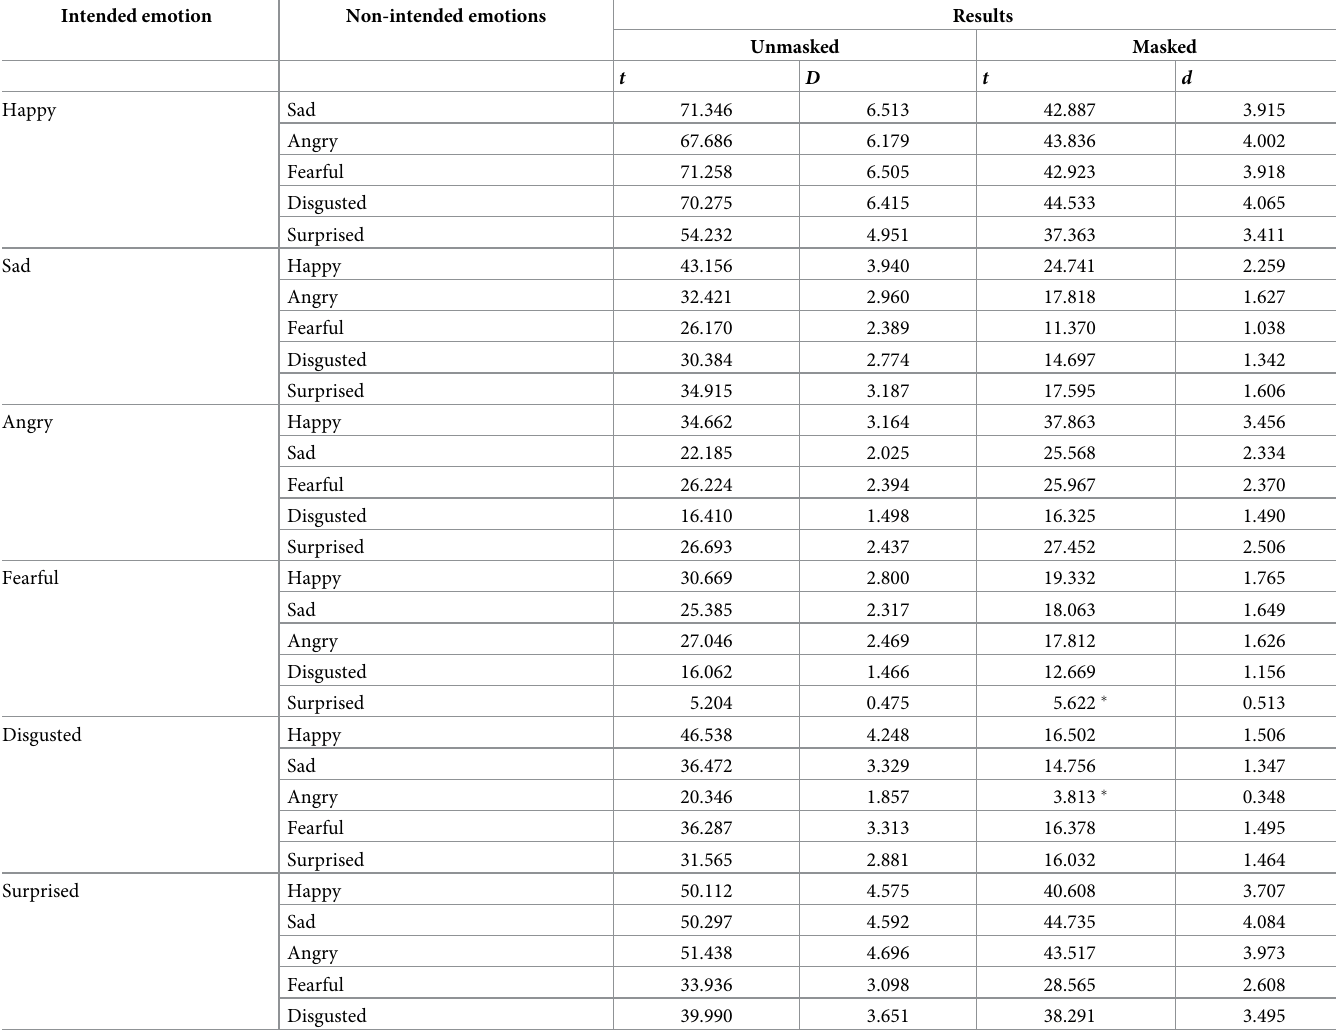
emotions across masked and unmasked faces, for each emotional expression we averaged across ratings of all five non-intended emotions. Ratings of non-intended emotions were sig- nificantly higher for masked faces compared with unmasked faces for expressions of happiness [ t (119) = 4.009, p < .001, d = 0.366], sadness [ t (119) = 10.222, p < .001, d = 0.933], anger [ t (119) = 2.317, p = .022, d = 0.212], fear [ t (119) = 5.729, p < .001, d = 0.523], and disgust [ t (119) = 14.385, p < .001, d = 1.313], but not for surprise [ t (119) = 1.847, p = .067, d = 0.169] (sub- jected to FDR correction for six comparisons). For neutral expressions, intensity ratings for sadness were higher than ratings of all other emotions for both unmasked and masked faces (all p ’s < .001; full results are presented in S1 Table). Unmasked neutral faces received higher intensity ratings for sadness than masked neu-